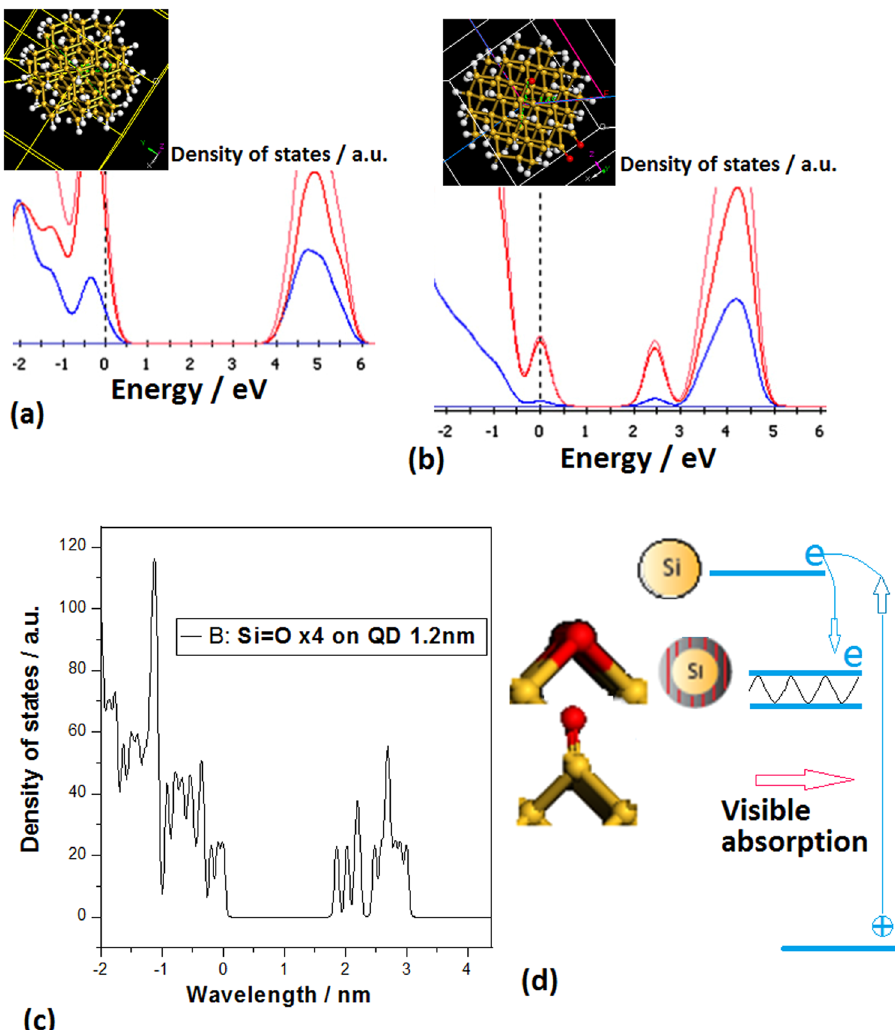
Figure 10. ( a ) The model structure of Si quantum dot (the inset:Si atom(yellow ball) and hydrogen atom(white ball)) and the DOS distribution in the first principle calculation; ( b ) The model structure of quantum dot doped with oxygen (the inset:Si atom(yellow ball), oxygen atom(red ball) and hydrogen atom(white ball)) and the DOS distribution in the first principle calculation, in which the localized states occur in the band gap; ( c ) The DOS distribution involving the localized states in the band gap in the first principle calculation related to Si = O bonds on Si QDs surface; ( d ) The forming model of the localized states on the pillars sample II prepared in